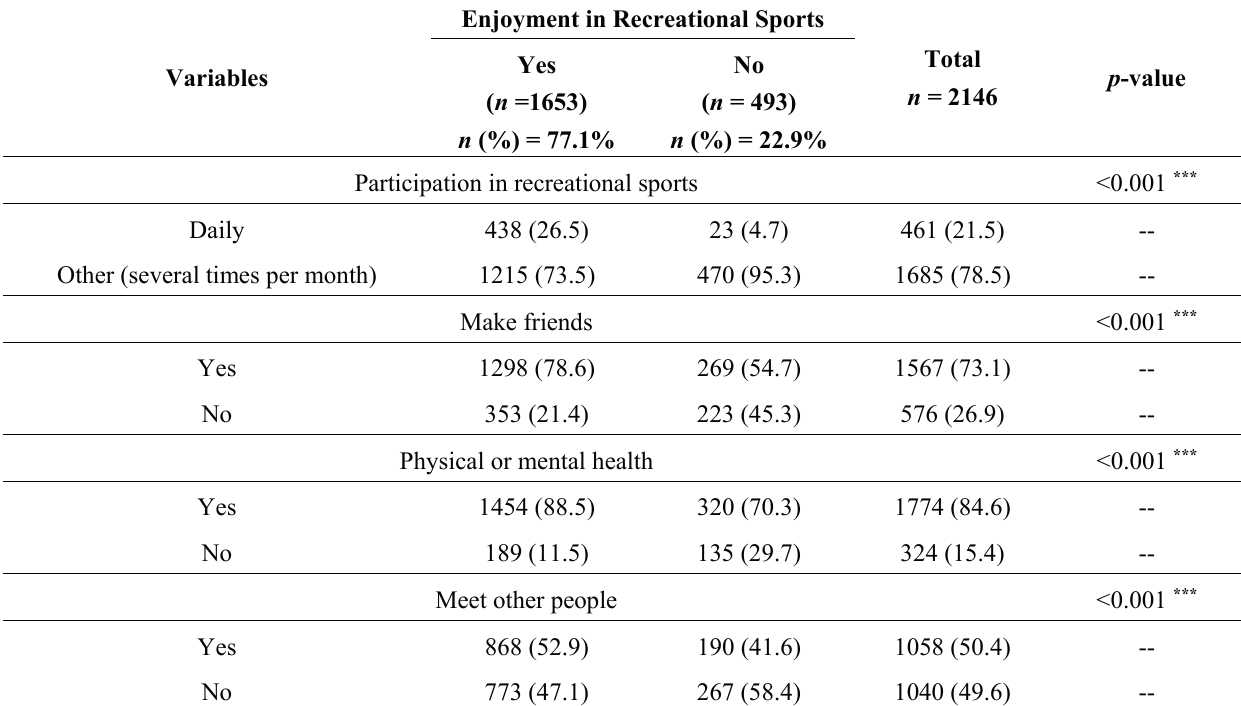
Table 2. Distribution of participants’ frequency characteristics among adults in Taiwan ( n =